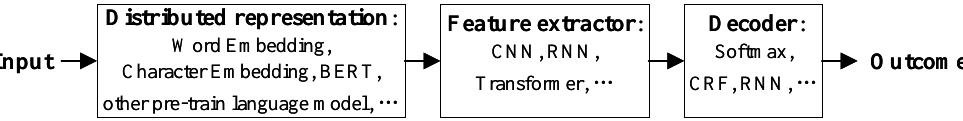
Figure 3. The deep learning approach for the NER